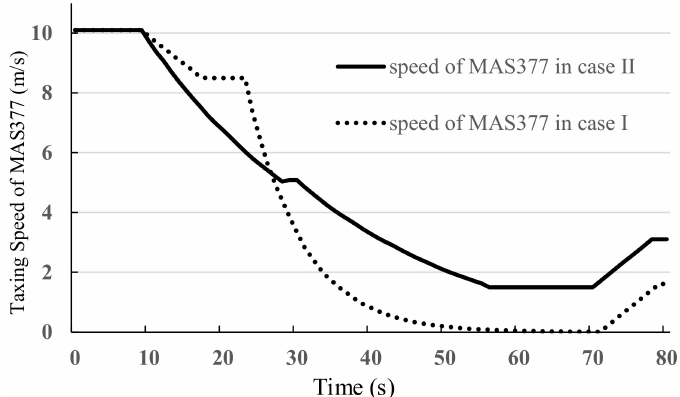
Figure 15. Taxing Speed Variations of MAS377 under Different Conditions.